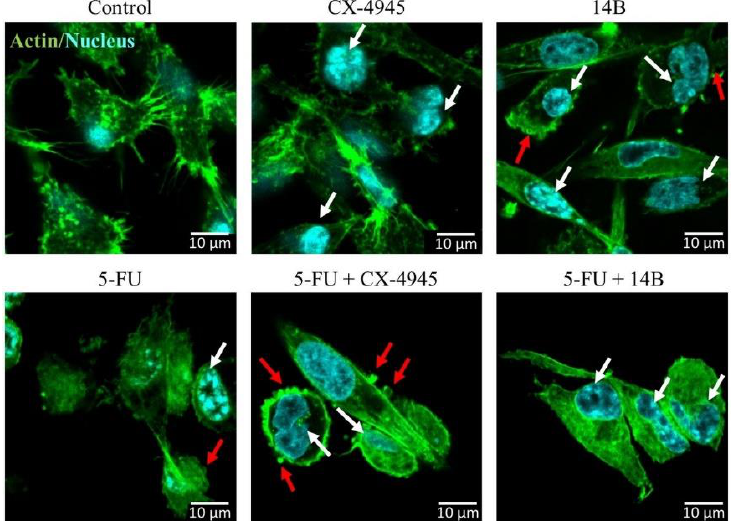
Figure 5. Confocal laser scanning microscopy examinations of MDA-MB-231 human breast cancer cells, untreated (control) or treated with 15 µM 5-FU, 2 µM 14B, and 5 µM CX-4945 used separately or in combinations for up to 72 h, then fixed and stained with Alexa Fluor 488 phalloidin (F-actin, green fluorescence) and Hoechst 342 (nuclei, cyan fluorescence). White arrows, abnormal cell nuclei (irregular nuclei with condensed chromatin); red arrows, blebs.